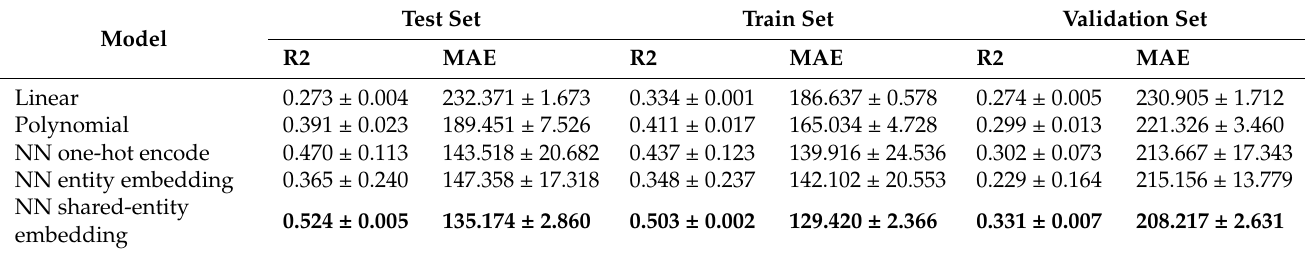
Table 9. Model performance without using observation-angle as the feature. The best performing models are in bold.